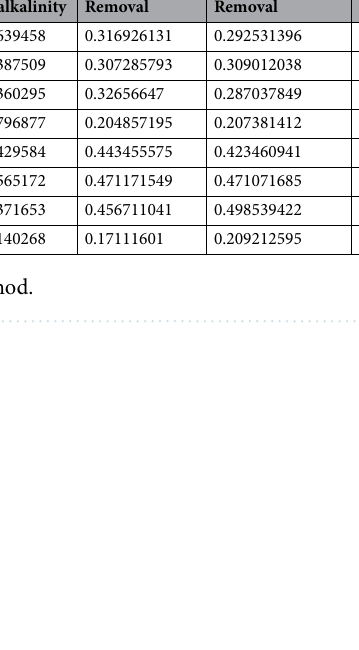
Table 8. Value of entropy, dispersion and weight of each alternative for VIKOR.